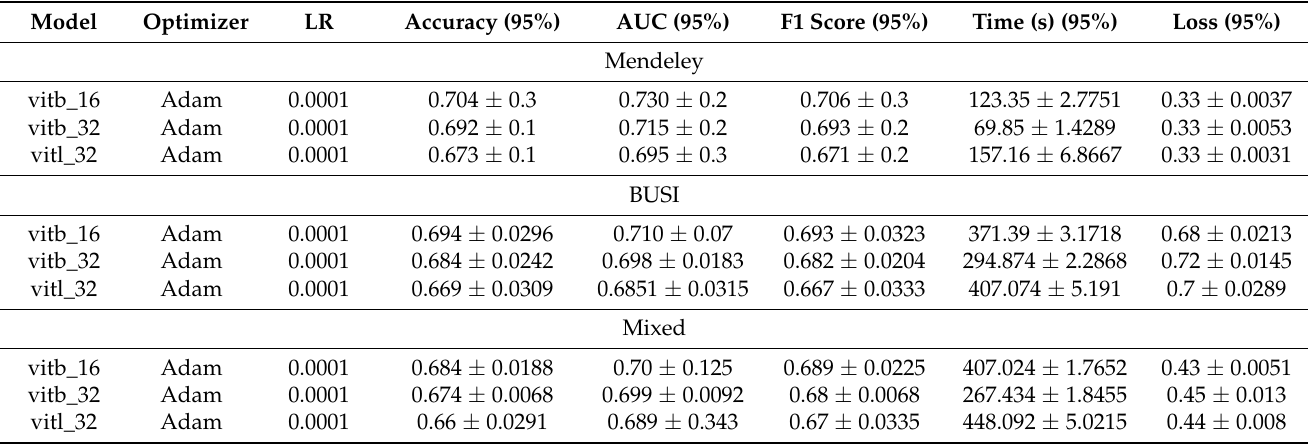
Table 4. Performance results of ViT models trained from scratch. BUSI, breast ultrasound image dataset; LR, learning rate; s, seconds; AUC, area under receiver operating